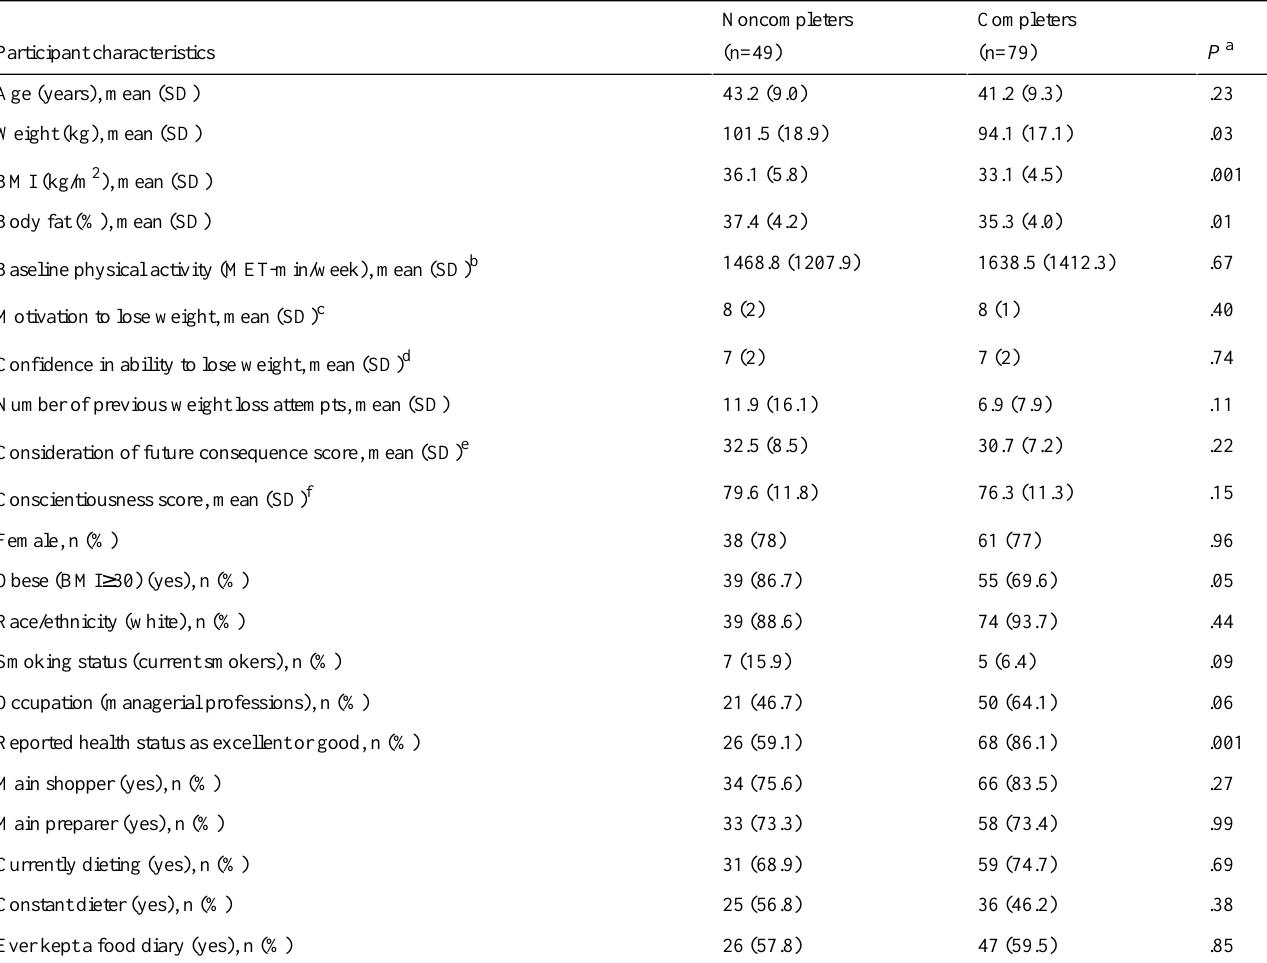
Table 2. Differences in baseline characteristics between trial completers and noncompleters at 6-month follow-up.